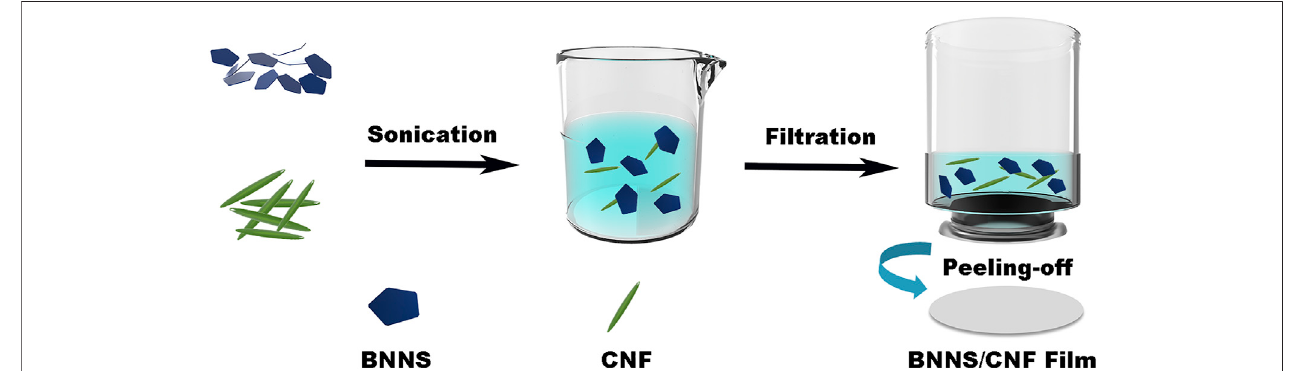
FIGURE 1 | Schematic diagram of the preparation of CNF/BNNS composite fi lm.